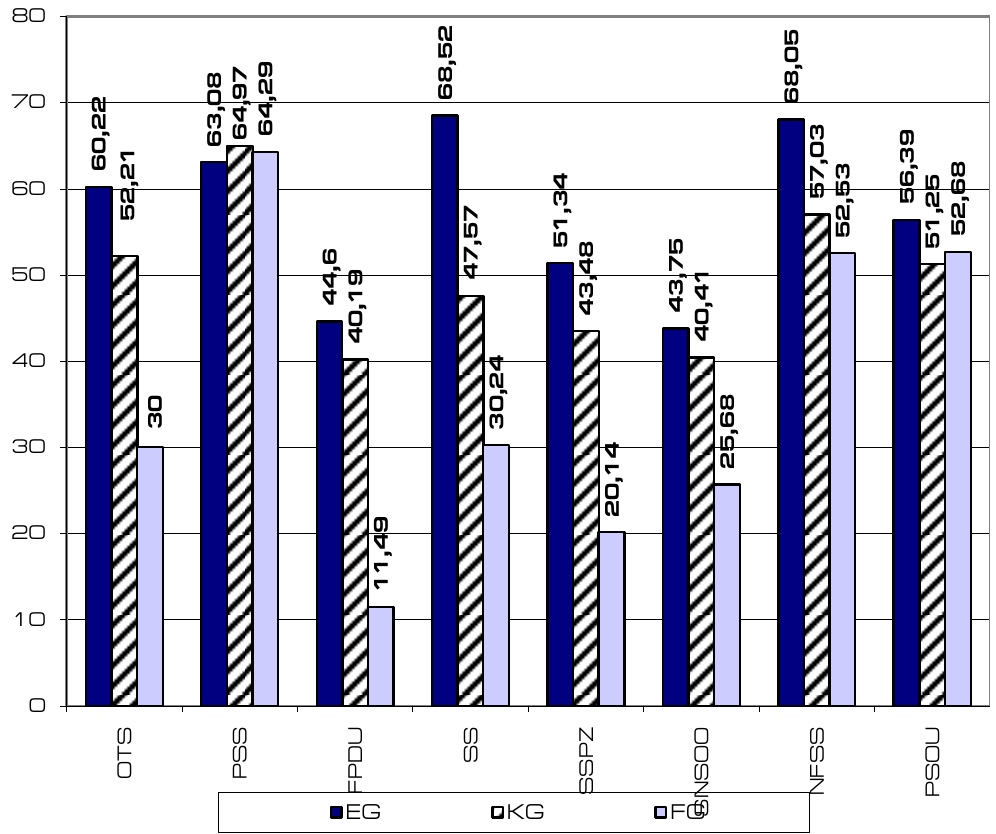
Fig.2 Changes of indicators of school anxiety (Fillips’ test) at experimental, control and background groups after experiment